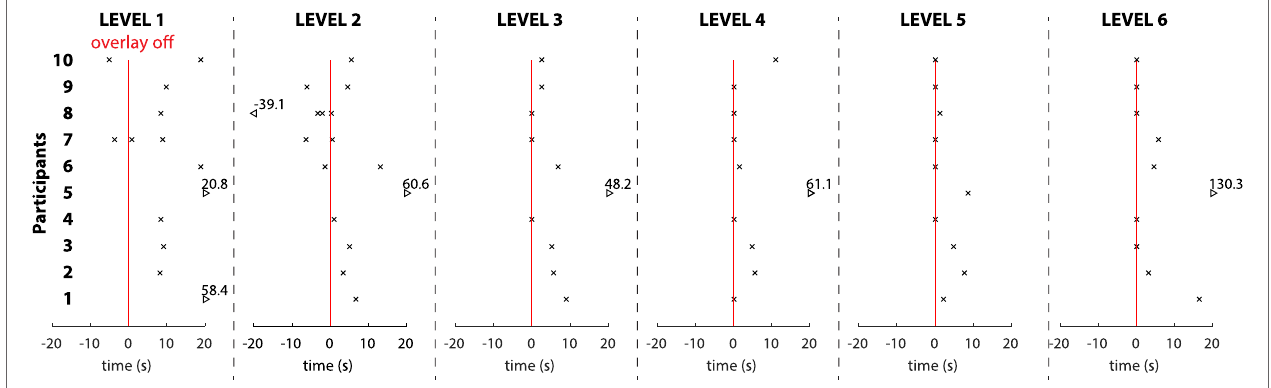
FigUre 6 | Event-related touch raster showing touches (as x’s) arranged around the removal of the overlay (the red line) on each level. The arrows indicate values that lie outside of the range of the plot. Each participant occupies one row on the Y-axis, and time is represented on the X-axis. The removal of the overlay is an important event within the interactive story as it indicates when the robot starts reacting to touches presented by the child. Children appear to adapt to the event of the overlay being removed—in earlier levels they touch the screen prior to removal and in later levels they do